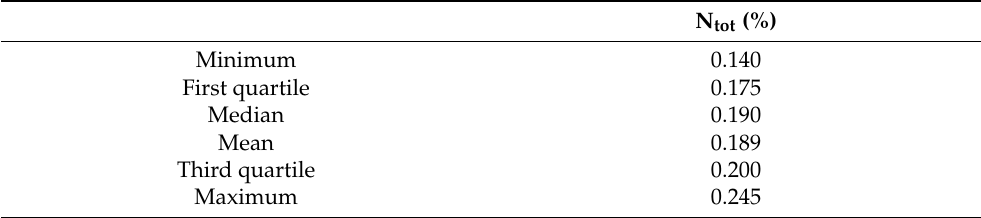
Table 3. Descriptive statistics of the total nitrogen content from 22 sampling